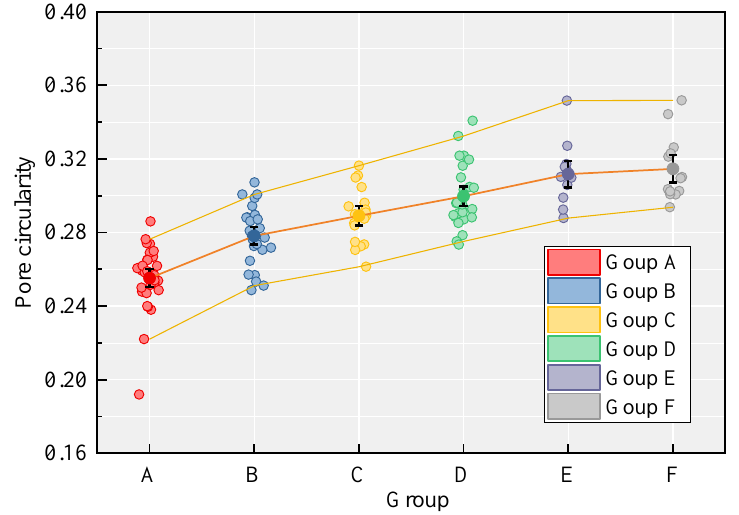
Figure 8. The curve of the circularity of pores under different consolidation time.